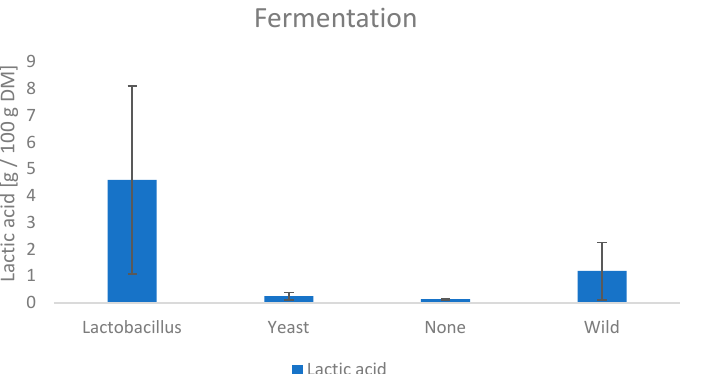
Figure 9. Influence of the fermentation on the lactic acid content.